Question: Which visualization type does this figure use?
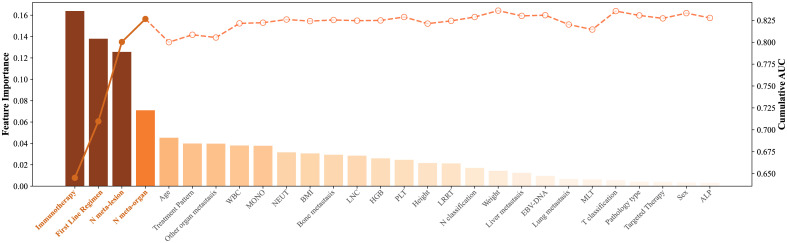
Answer: line